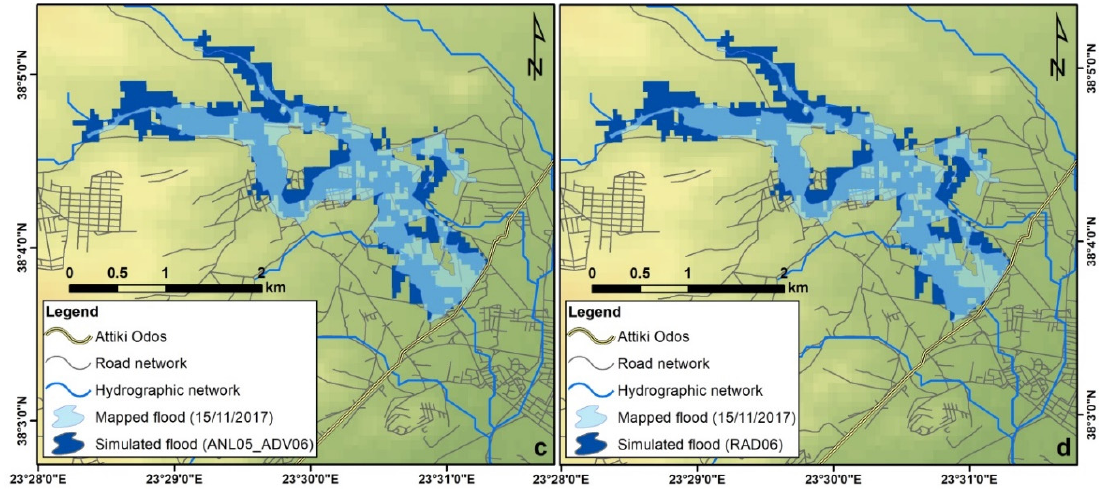
Figure 8. Flood extent produced by the three WRF-Hydro simulations (in dark blue), starting ( a ) on 15 November at 02:00 UTC and going up to 06:00 UTC, forced by the LAPS nowcasts from 03:00 to 06:00 UTC; ( b ) starting at 03:00 UTC and going up to 06:00 UTC, forced by LAPS nowcasts from 04:00 to 06:00 UTC; ( c ) starting at 04:00 UTC and going up to 06:00 UTC, forced by the LAPS nowcasts from 03:00 to 06:00 UTC. Additionally, the flood extent produced by the hindcasting WRF-Hydro flood simulation using only the XPOL data [36] is shown in ( d ). Flood extent mapped by the FloodHub group of the BEYOND project is also shown (in light blue).